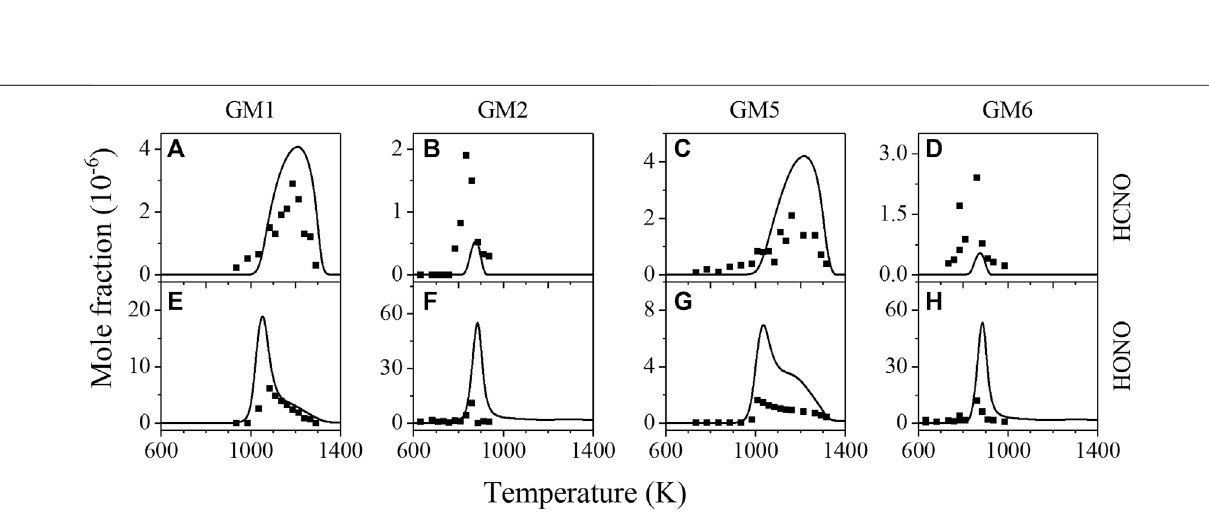
Frontiers in Energy Research |